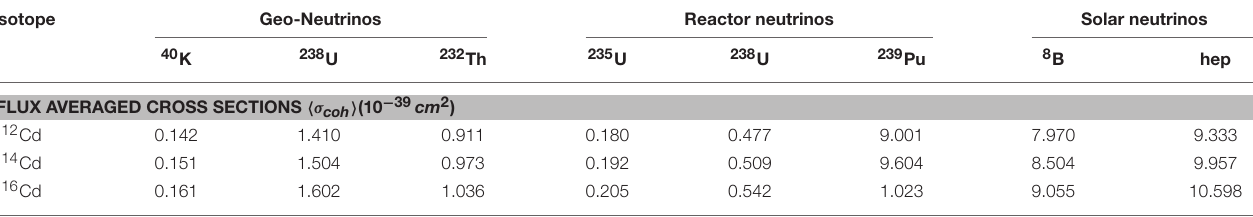
σ coh (in units 10 − 39 cm 2 ) for 112 Cd, 114 Cd, and 116 Cd isotopes. h i